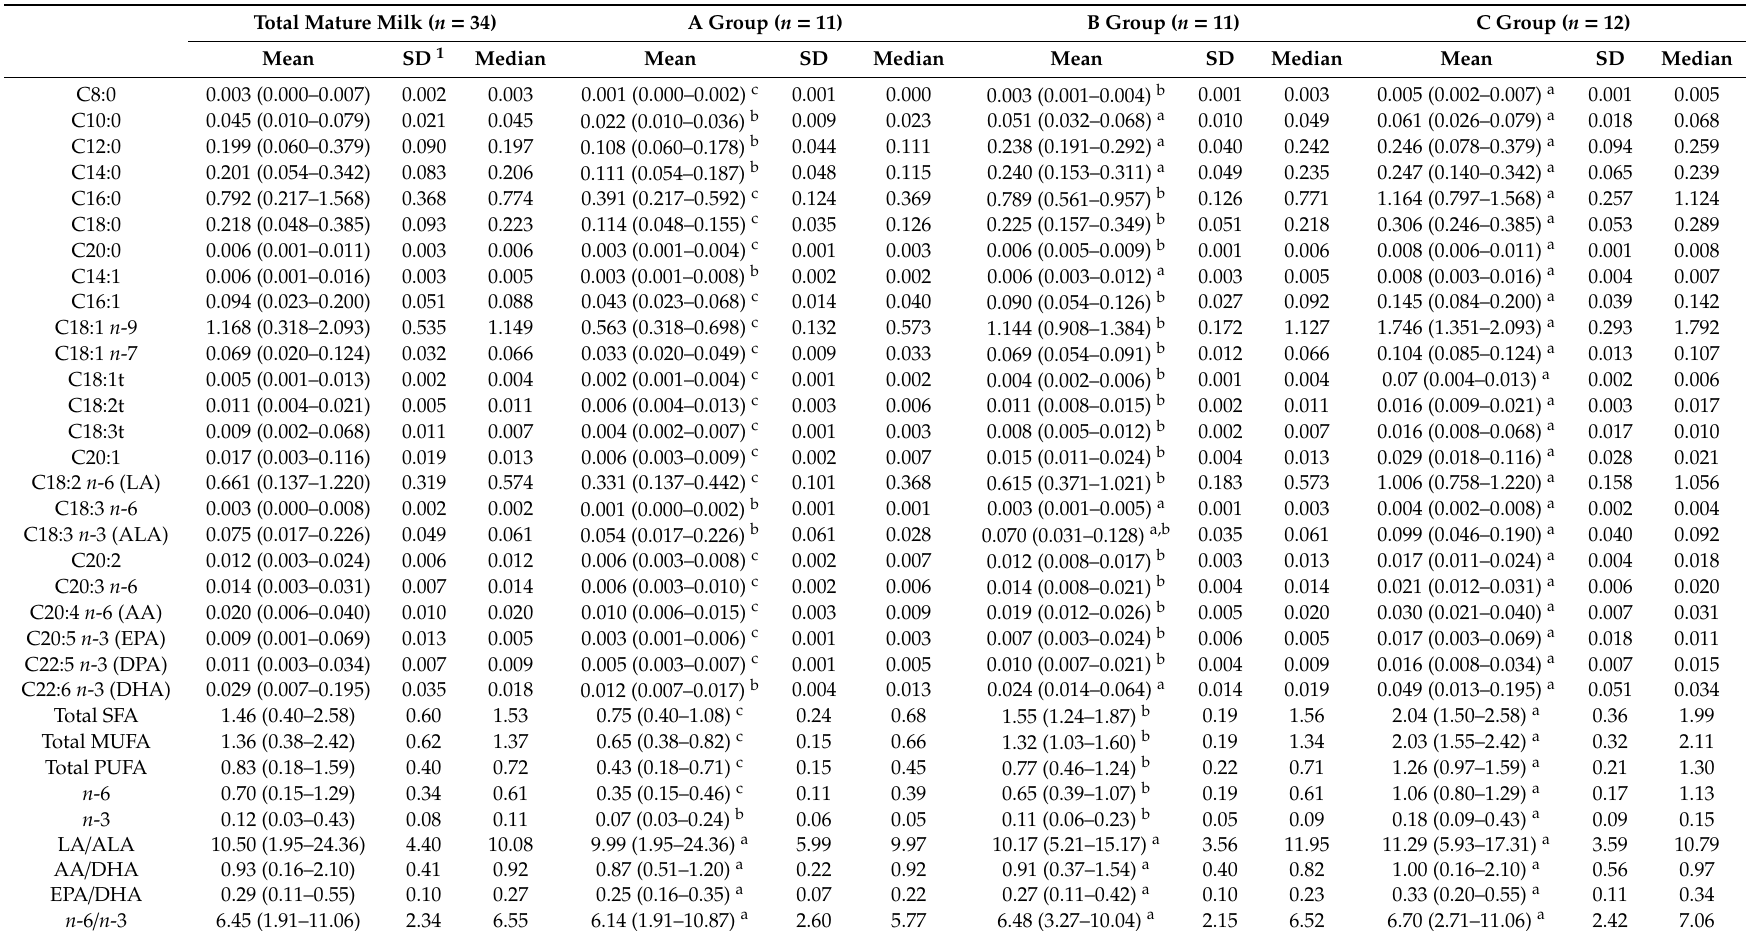
Table 3. Contents of fatty acids in human milk from mothers in Korea (g / 100